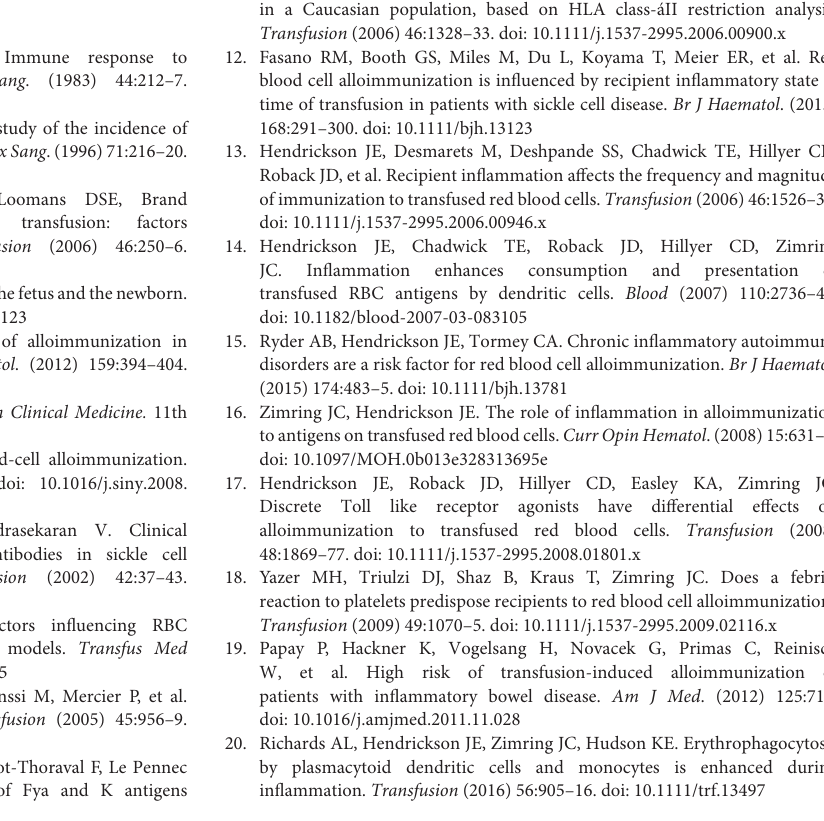
Supplementary Figure 5 | No immunological synapse formation between RPMs, media alone, or PMA/Ion treatment. Recipient B6 mice were treated with 200 ug of poly (I:C) or control PBS and subsequently transfused with 100 uL of leukoreduced, packed, DiO-labeled HOD RBCs. Spleens were harvested 18–24h post transfusion, collagenase digested, and stained with antibodies to delineate individual APC populations. DiO + CD11c − / lo CD11b − / lo F4/80 + RPMs were sorted and co-cultured at a 10:1 ratio with CD4 enriched OTII T cells labeled with CFSE-FR. OTIIs were stimulated with PMA/Ion for a positive control or in media alone for a negative control. After 2 days in culture, cells were harvested and stained to identify immune synapses. The immunological synapse was determined by co-expression of Va2, CD4, MHCII, and CD18 (also known as LFA-1). Images are from the immune synapse region based on the gating strategy in Supplementary Figure 4 . Images are representative from 3 independent